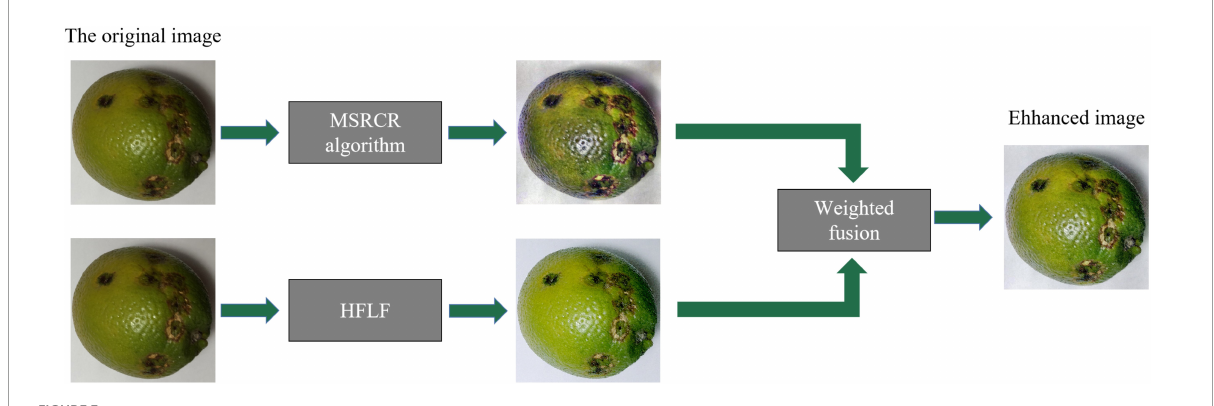
FIGURE3 HFLF-MS working principle